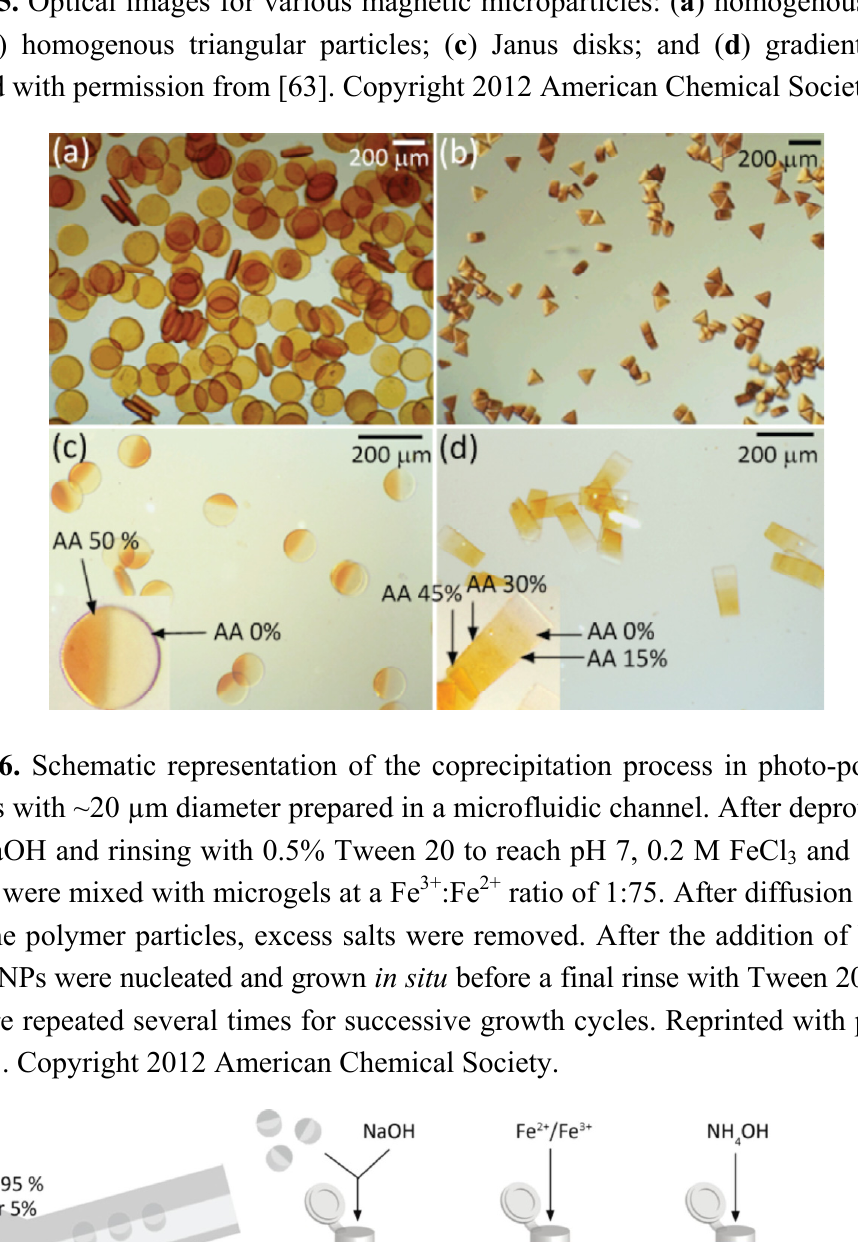
Figure 35. Optical images for various magnetic microparticles: ( a ) homogenous magnetic disks; ( b ) homogenous triangular particles; ( c ) Janus disks; and ( d ) gradient particles. Reprinted with permission from [63]. Copyright 2012 American Chemical Society.